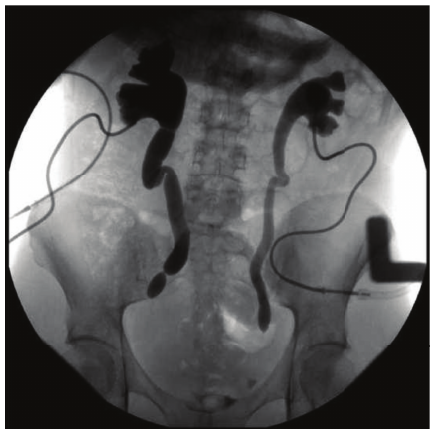
Figure 2: Antegrade pyelogram demonstrating multiple ureteral strictures and absence of contrast in bladder. Percutaneous nephros- tomy tubes are